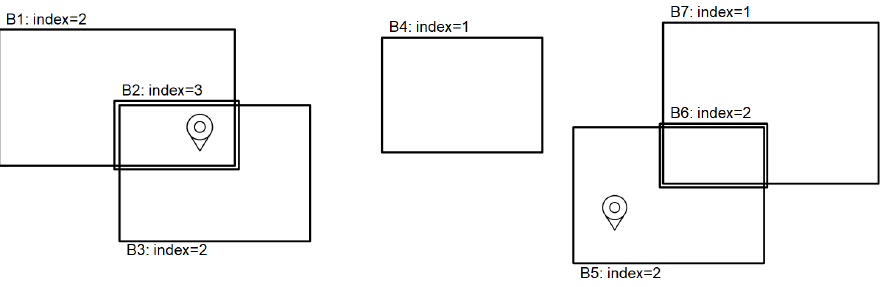
Figure 2. Simplified polygon stacking procedure. New bounding boxes are created at intersections, with increased index (for example B2 and B6). Geotags increment the index of all bounding boxes that include